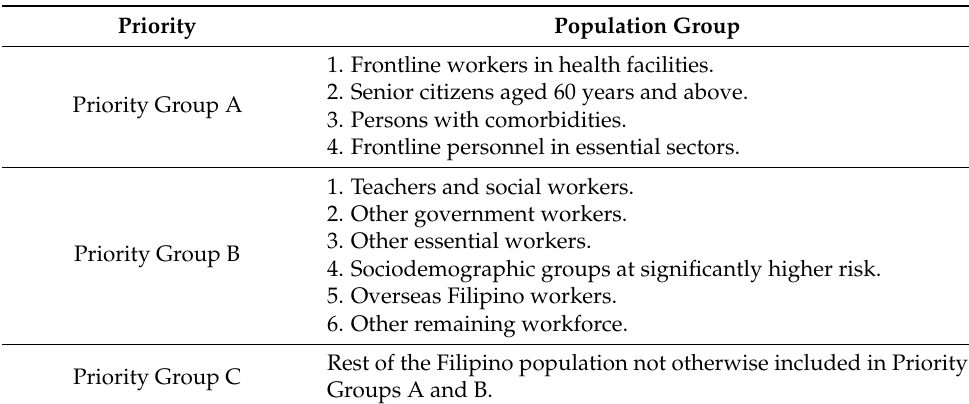
Table 1. Priority eligible population group in the Philippines [10]. This table shows three groups (A, B, and C), which specifies the level of prioritization in the vaccination rollout of the Philippine